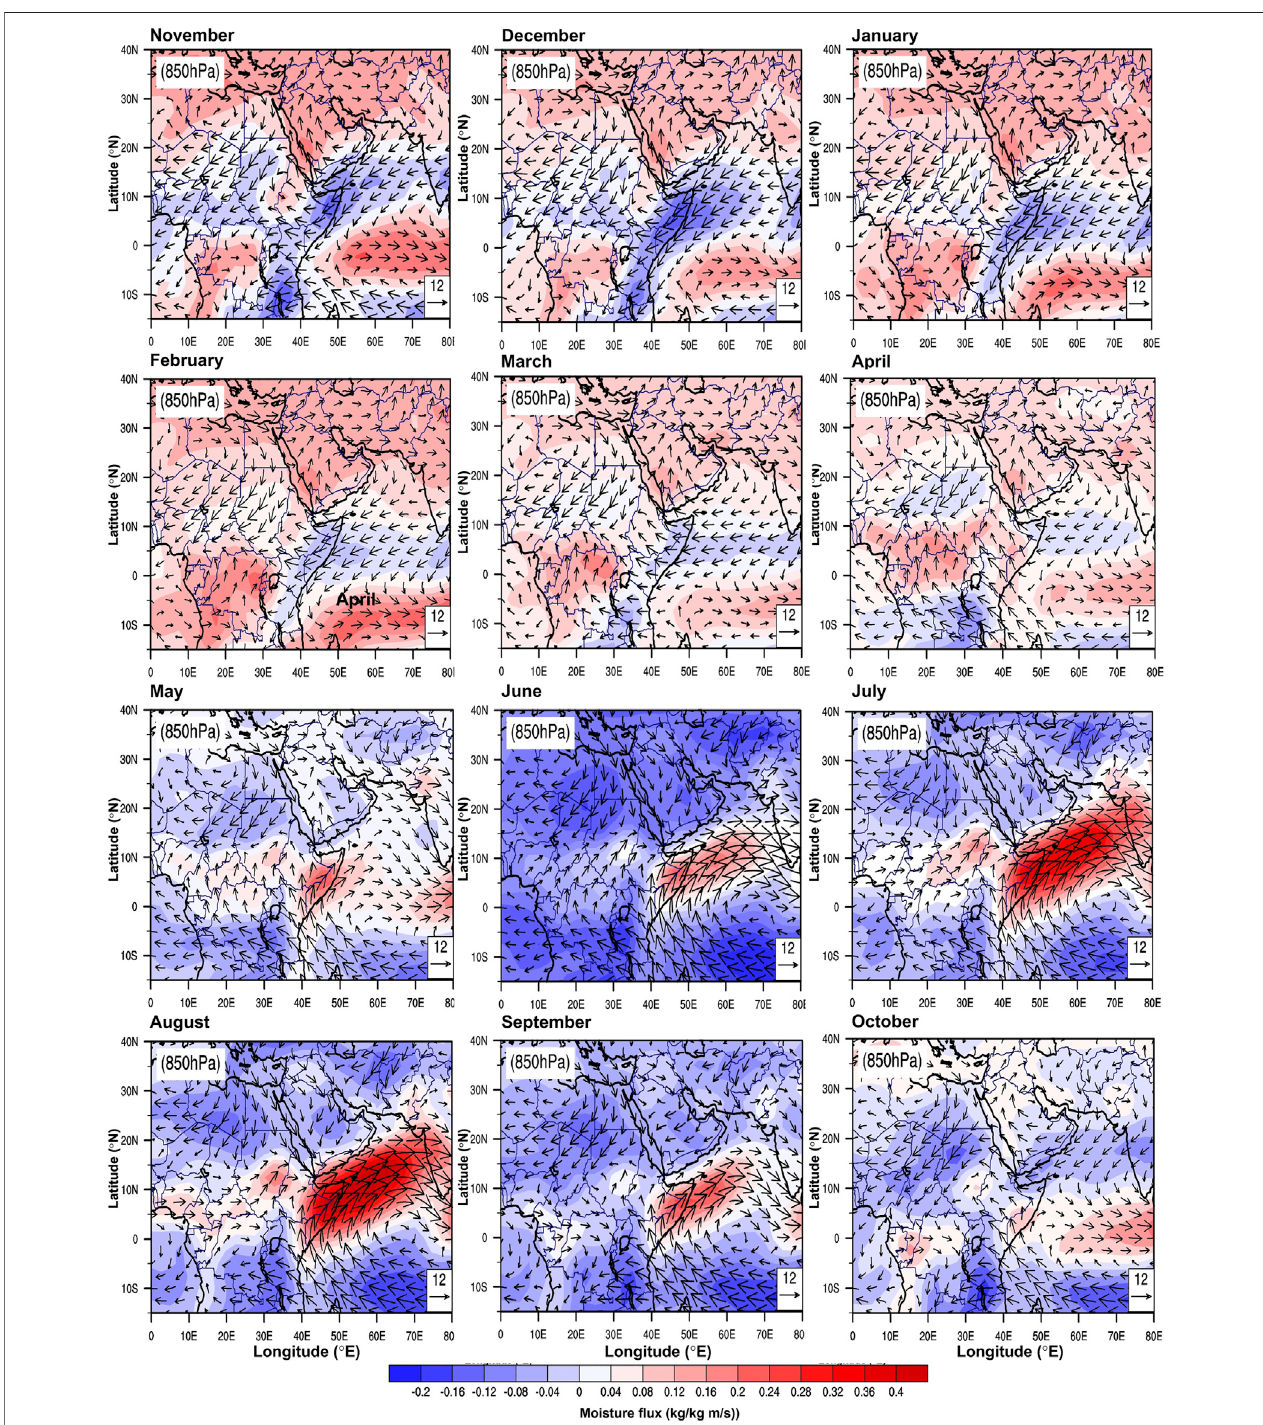
FIGURE 2 | Monthly variations in mean wind vector and moisture fl ux at 850 hPa over the Sudanese region between 1981 and 2010.